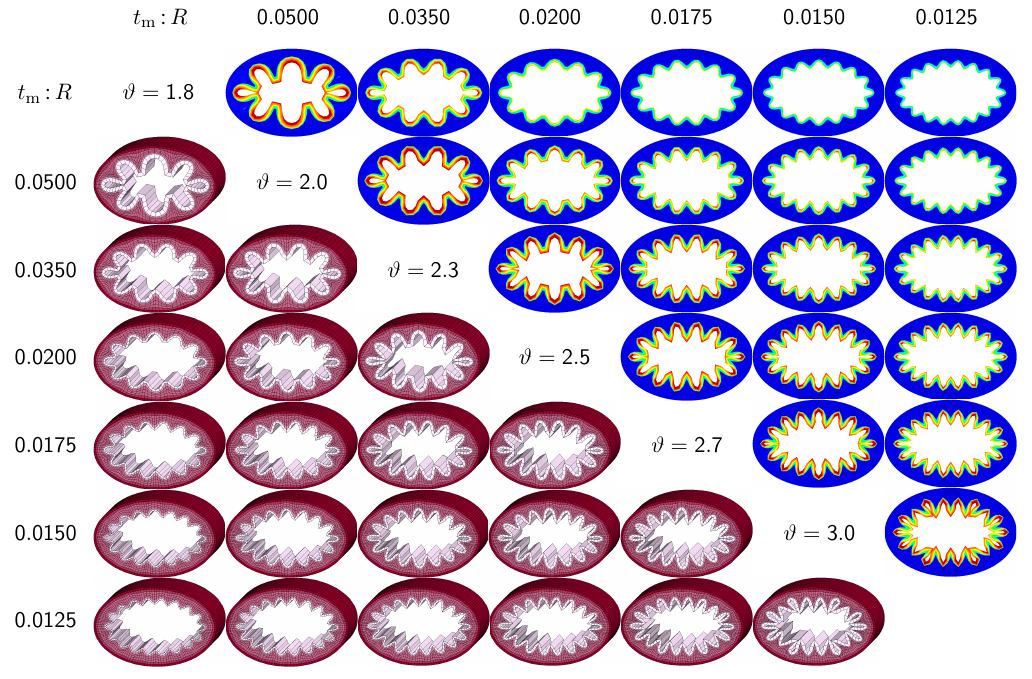
Figure 8. Sensitivity of the failure mode with respect to relative mucosal thickness for severely elliptical cross-section with R